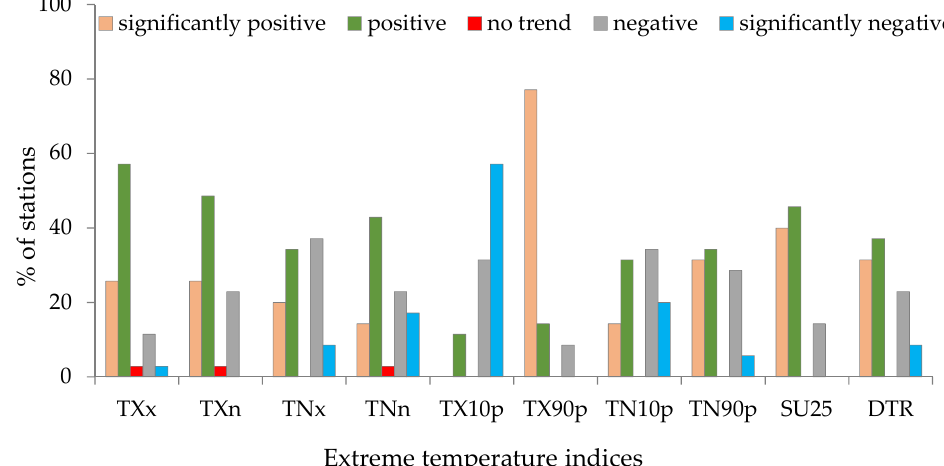
Figure 7. Percentage of all stations with significantly positive, positive, no trend, negative, significantly negative in extreme temperature indices.